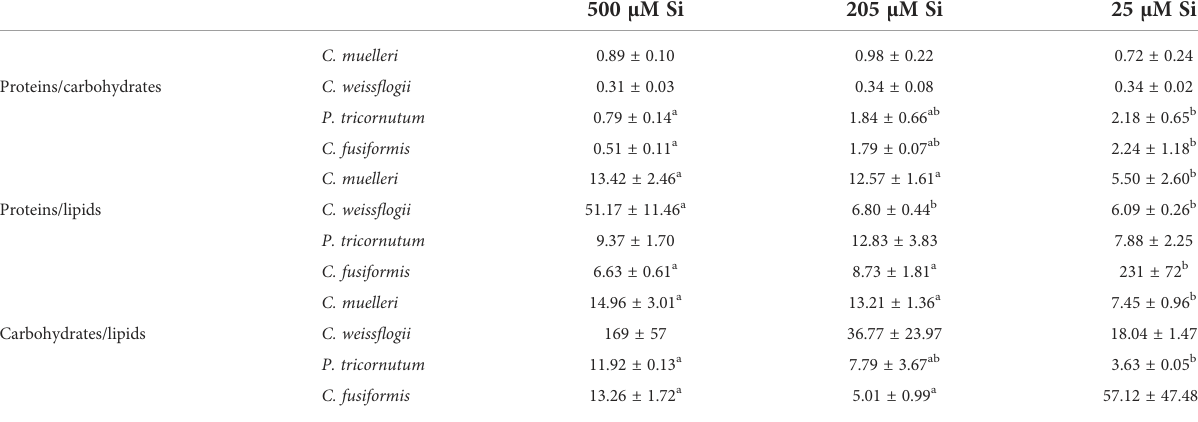
TABLE 5 Macromolecular pool ratios (arbitrary unit) for the four diatoms acclimated to different paleoenvironments.